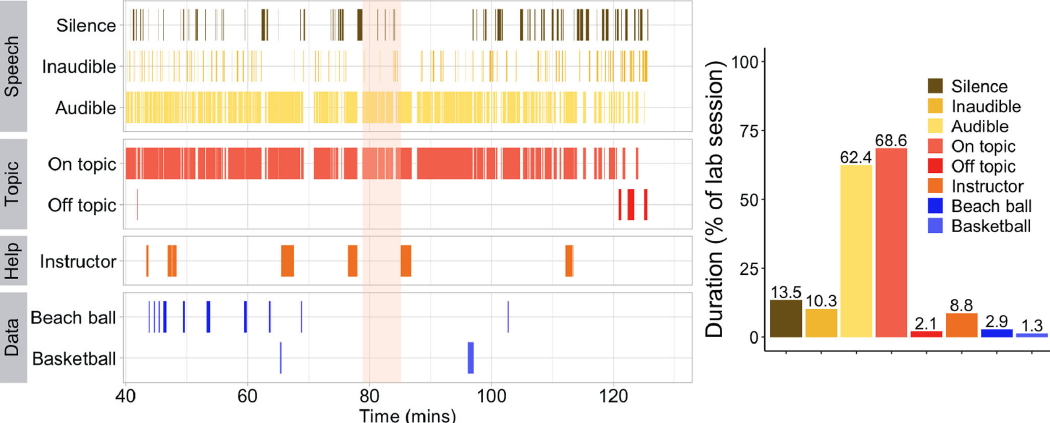
FIG. 11. Group B full timeline highlighting episode analyzed in Ref. [20] and durations of each behavior as a percentage of the video